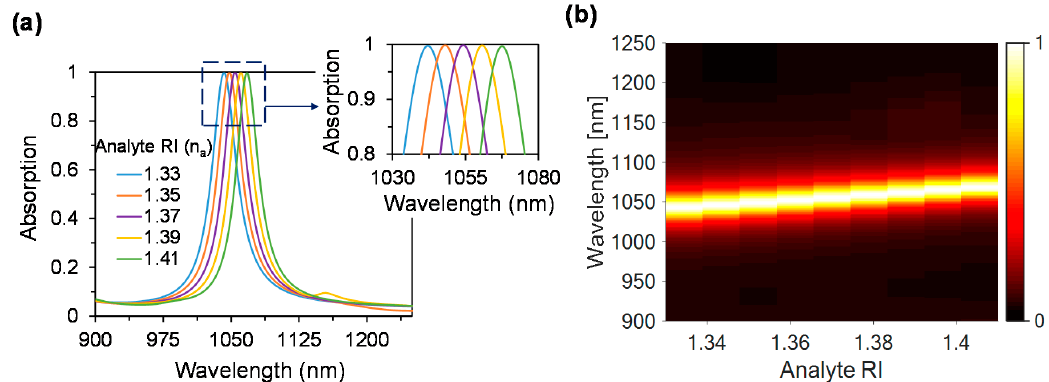
Figure 5. ( a ) Absorption spectra for various analytes from 1.33 to 1.41, and ( b ) Full 2D representation.